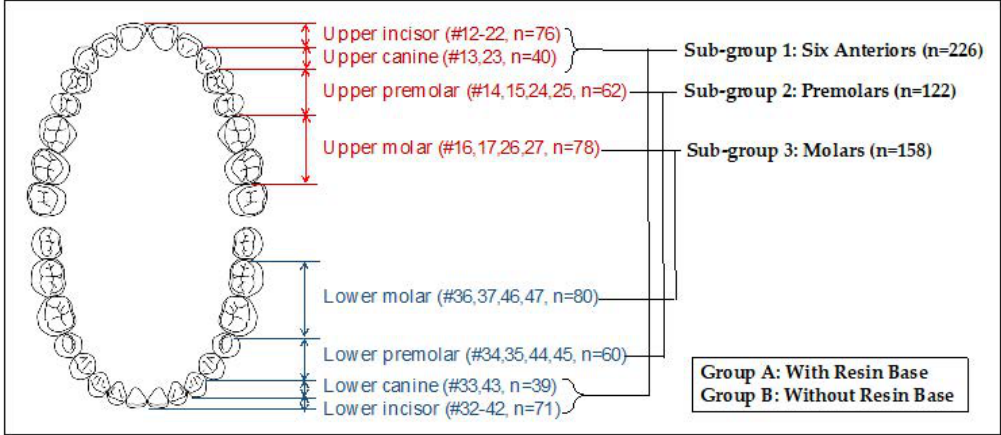
Figure 5. Schematic diagram of the experimental group. All subjects were classified into two groups depending on the presence or absence of a resin base (Group A: with resin base, Group B: without resin base). In addition, sub-groups were organized by tooth type. Sub-group 1 had six anterior teeth, a total of 226 subjects. Sub-groups 2 and 3 were the premolar and molar teeth, respectively, with a total of 112 and 158